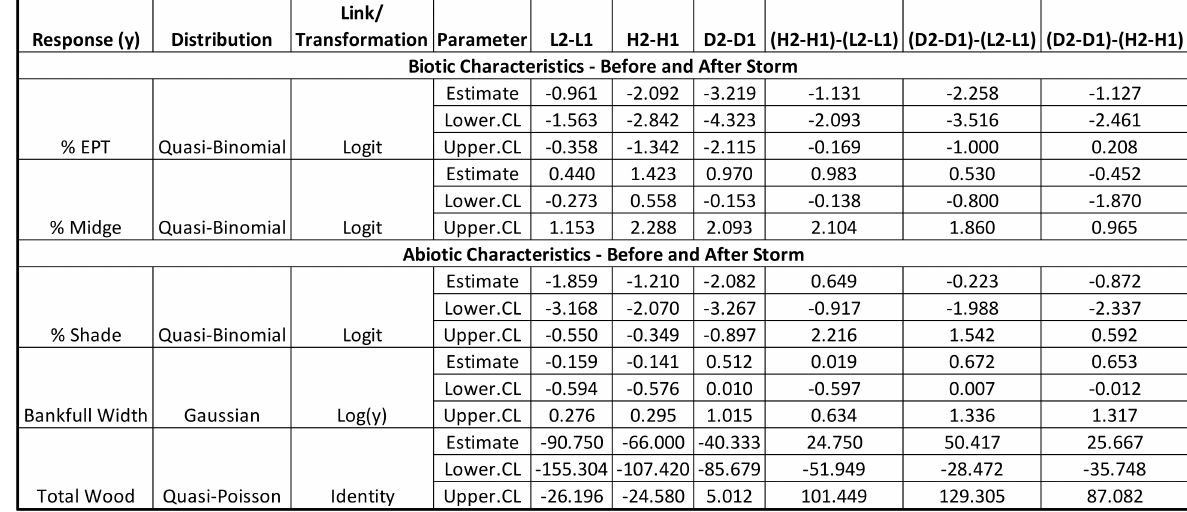
Figure A1. Contrasts of two biotic (% EPT and % Chironomidae) and four abiotic characteristics (% shade, bankfull width, % pool, and total wood) before and after 2007 storm at low flood ( L ), high flood ( H ), and debris flow ( D ) disturbance categories. First set estimate differences is before and after for each category. The second, the difference between the difference of H and L, D and L, and D and H.